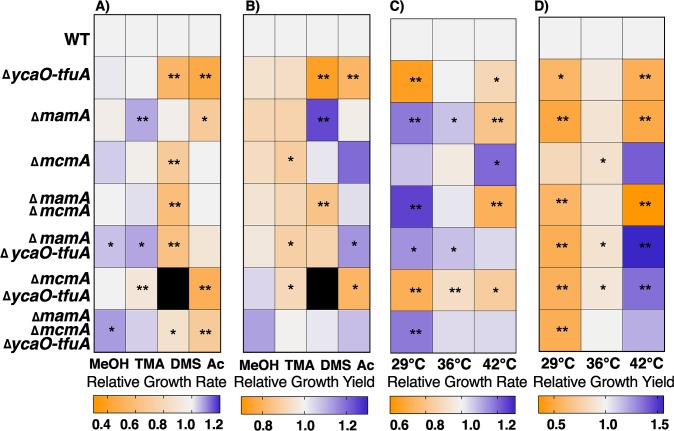
Phenotypic analyses on methanogenic substrates.Heat maps depicting (A) growth rate or (B) growth yield (measured as the maximum optical density at 600 nm) of mutants lacking ycaO-tfuA, mcmA, and mamA in all possible combinations relative to wild type in bicarbonate-buffered HS medium supplemented with 125 mM MeOH, 50 mM TMA, 20 mM DMS, or 40 mM Ac as the methanogenic substrates. All growth assays were performed at 36°C. Heat maps depicting (C) growth rate or (D) growth yield (measured as the maximum optical density at 600 nm) of mutants in bicarbonate-buffered HS medium supplemented with 50 mM TMA at three different temperatures as indicated. Statistically significant differences in growth parameters (p < 0.05 or p < 0.01) relative to the wild type as determined by a two-sided t test are indicated with * and **, respectively. The black box for the ΔmcmAΔycaO-tfuA mutant in DMS-supplemented HS medium indicates that no measurable growth was detected after 6 mo of incubation. The primary data used to construct the heat maps are presented in S2–S13 Tables. Ac, sodium acetate; DMS, dimethyl sulfide; HS, high-salt; mamA, methylarginine modification; mcmA, methylcysteine modification; MeOH, methanol; TMA, trimethylamine.